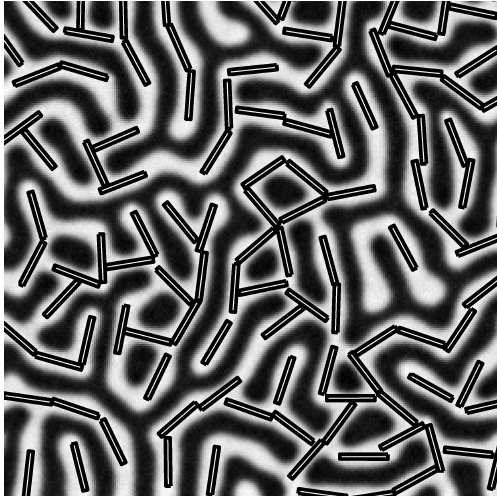
Figure 14. Alignment of rectangular NPs in a symmetric block copolymer. NP size is a / L 0 = 1.5 and b / L 0 = 0.15 for the major and minor semiaxis, for a lamellar spacing L 0 . Reprinted with permission from Ref. [160] Copyright 2019 American Chemical